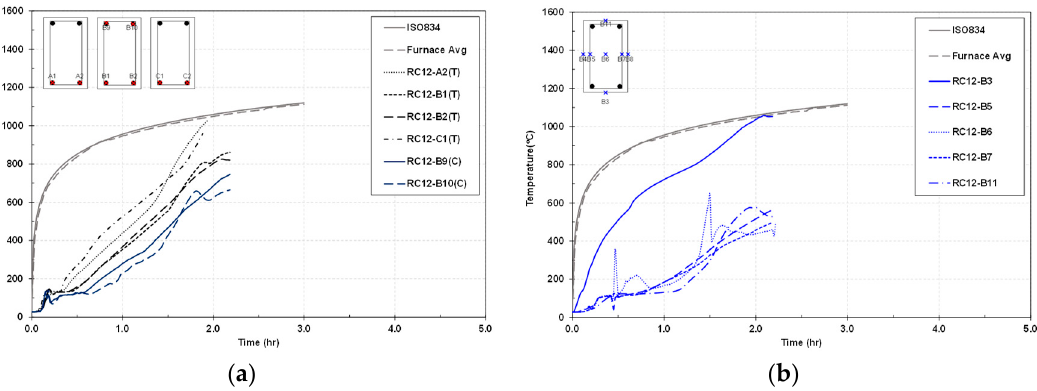
Figure 7. Temperature versus time relationship in the beam RC12. ( a ) Reinforcement; ( b ) concrete.